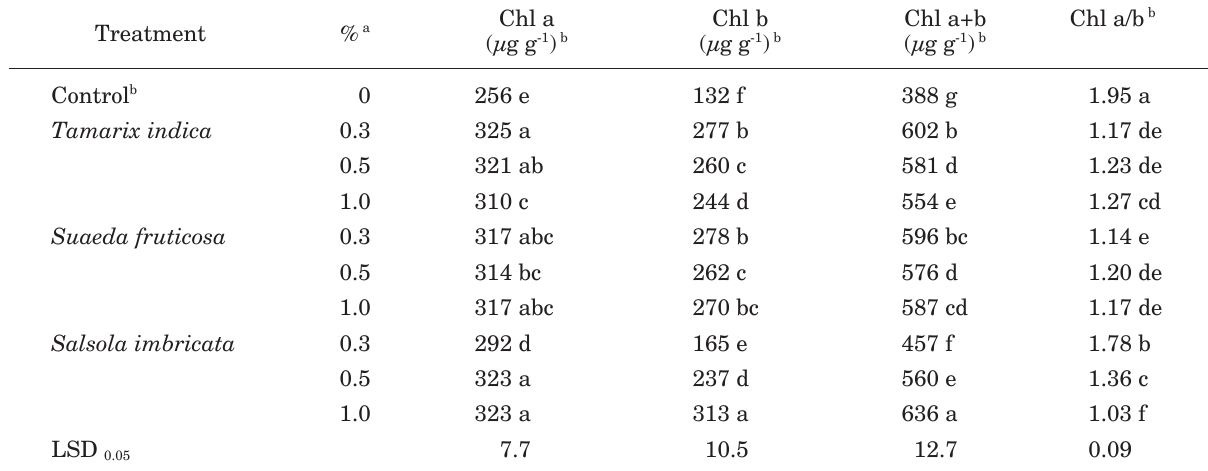
Table 4. Effect of three halophytes on the chlorophyll contents of eggplant infected with Meloidogyne javanica .